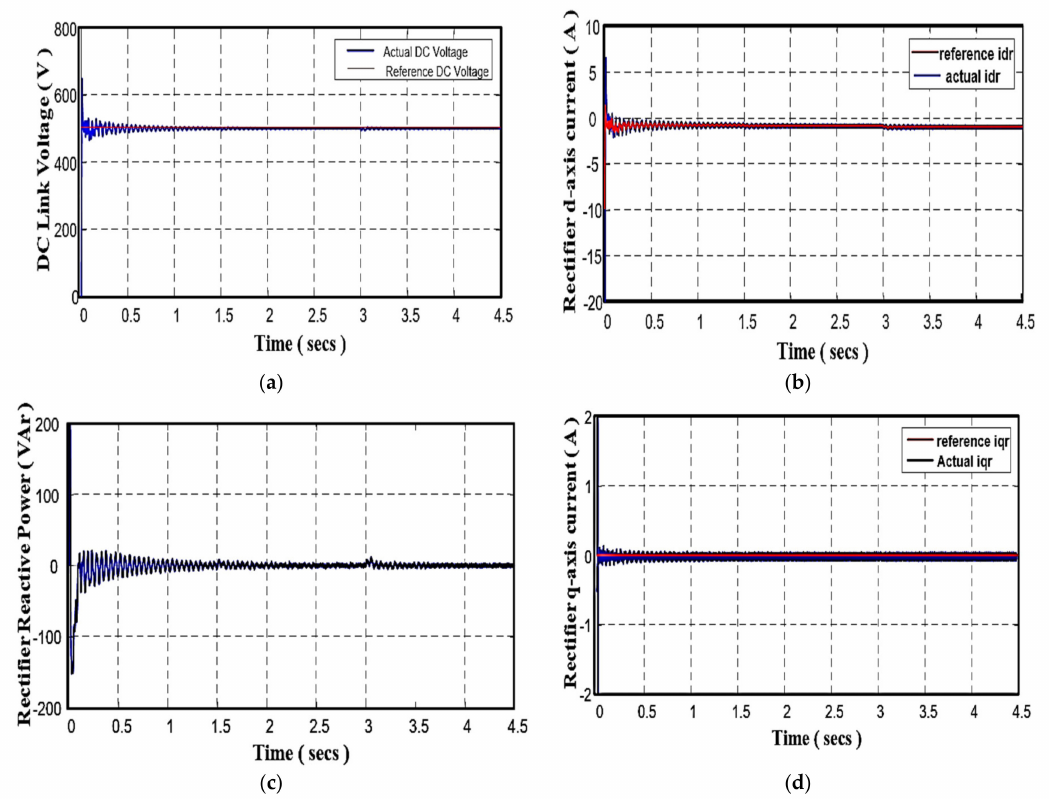
Figure 8. Voltage source rectifier (VSR) performance simulation: ( a ) direct current (DC)-link voltage, ( b ) reference and actual d -axis rectifier current, ( c ) rectifier reactive power, ( d ) reference and actual q -axis rectifier